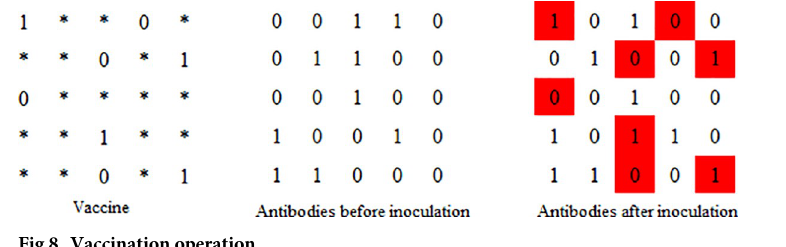
Fig 8. Vaccination